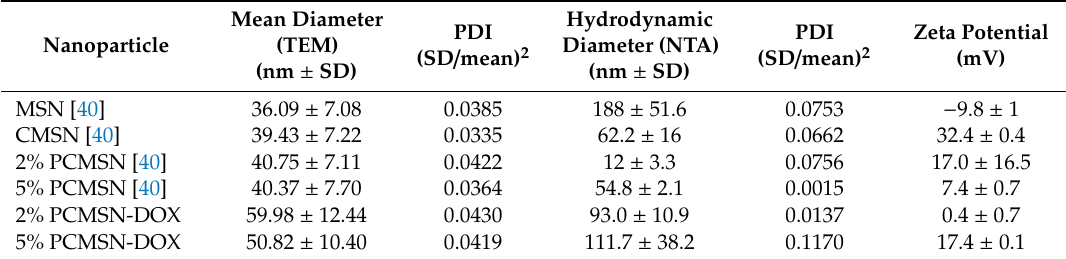
Table 1. Size, PDI and zeta potential of all MSNs and DOX-loaded